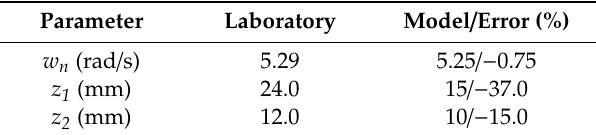
Table 5. Natural frequency w n and first and second oscillation amplitude z 1 and z 2 : comparison between laboratory data and model results, with their relative errors.